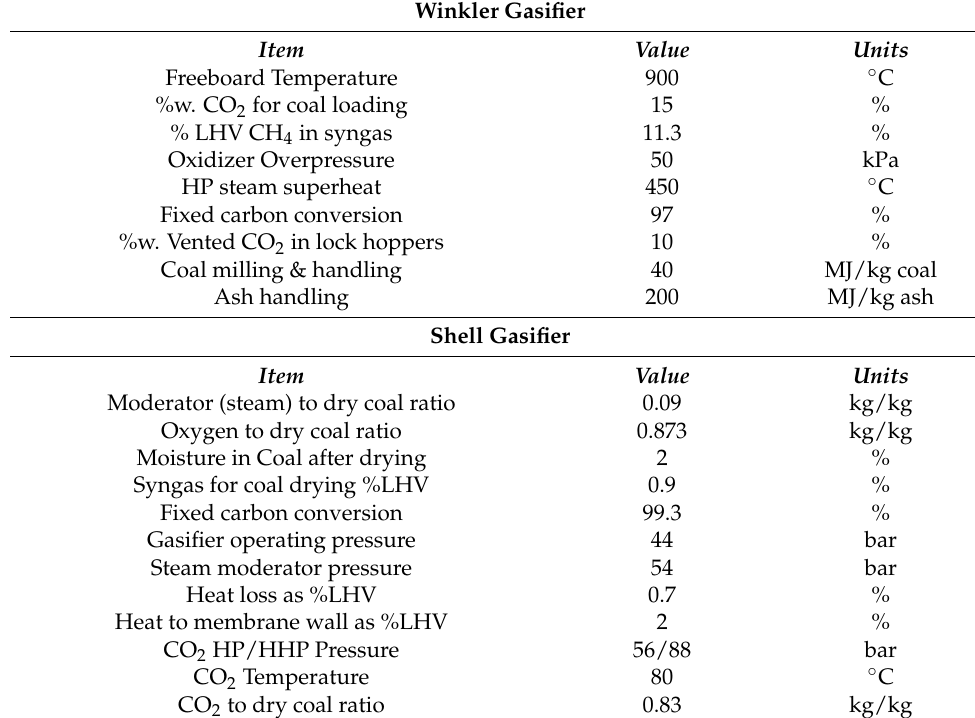
Table A1. Gasification island